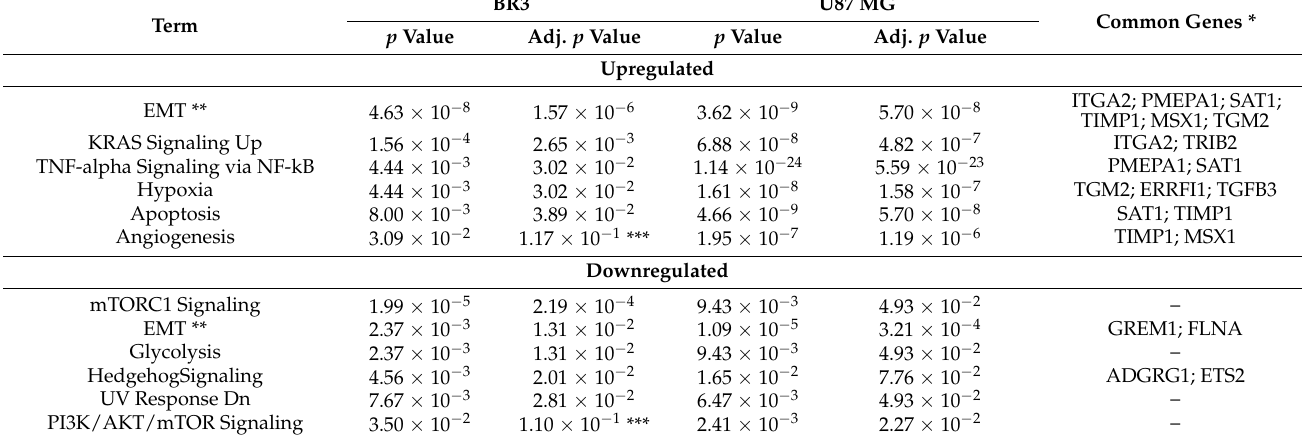
Table 2. Cellular processes and signaling pathways. Common for differentially expressed mRNAs of U87 MG and BR3 NS cellular processes and signaling pathways determined using Enrichr. Enrichr records (library “MSigDB Hallmark 2020”), ordered by ascending p value of BR3.